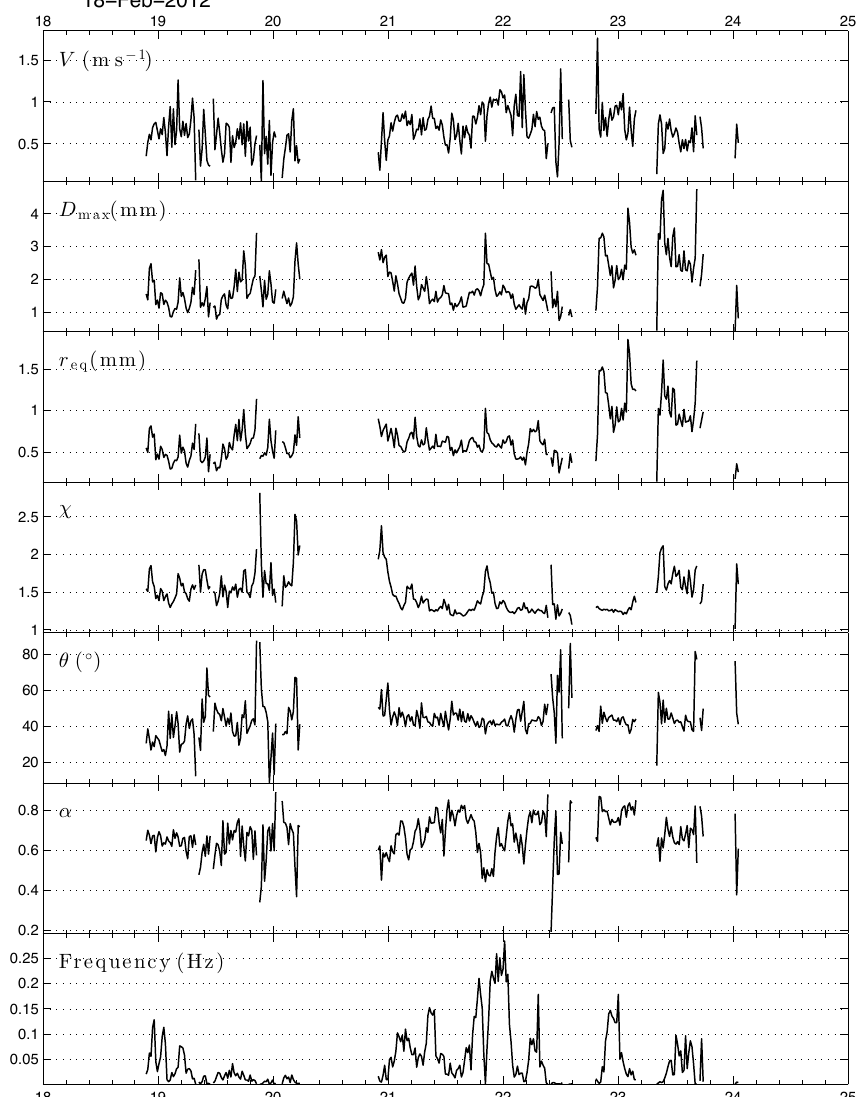
Fig. 4. A time series of analyzed parameters from MASC photography and fall speed data over a one week period beginning 18 Febru- ary 2012. The timestamp is in